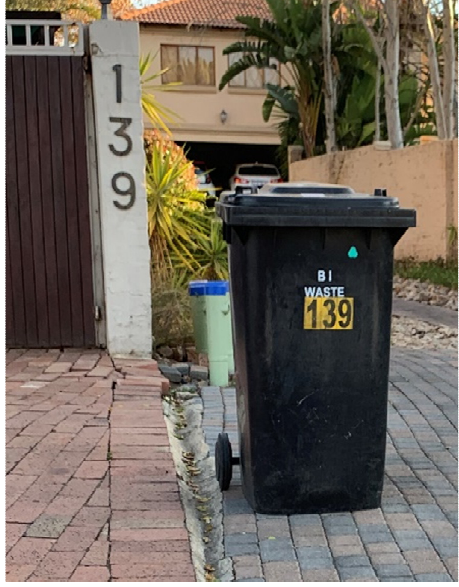
Figure 3. Illustration of a municipal-issued wheelie bin to a formal dwelling.